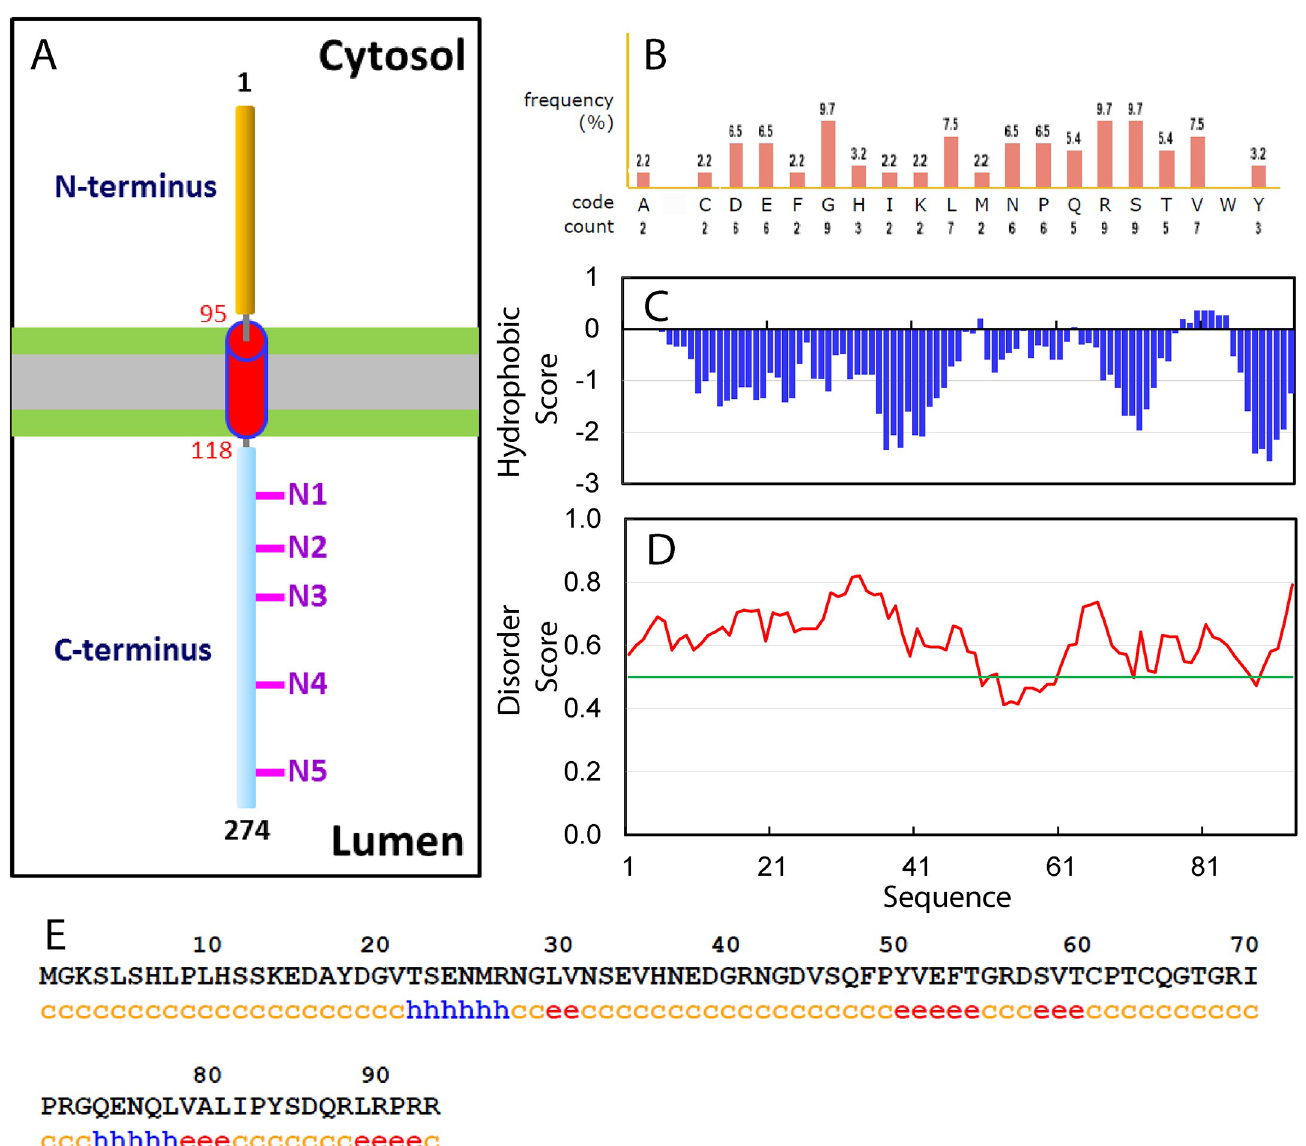
Fig 1. Bioinformatics analysis of the TMEM106B cytoplasmic domain. (A) A model of the TMEM106B transmembrane topology. N1–N5 indicates the five potential glycosylation motifs within the luminal C-terminus of TMEM106B. (B) Amino acid composition of the TMEM106B cytoplasmic domain. (C) Kyte & Doolittle Hydrophobicity Score. (D) Disorder Score predicted by IUPred program, which ranges between 0 and 1. Scores above 0.5 (green line) indicate disorder. (E) Secondary structures predicted by GOR4 program: c: random coil, h: helix and e: extended strand.